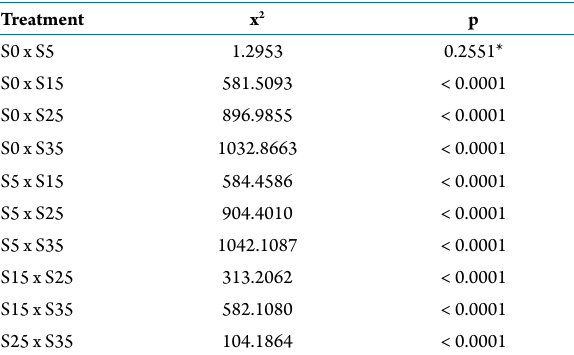
Table 1. Leptuca leptodactyla . Log-Rank test result applied to detect differences in larval survival among the five salinity treatments. S0: 0 PSU; S5: 5 PSU; S15: 15 PSU; S25: 25 PSU and S35: 35 PSU. * statistically not significant